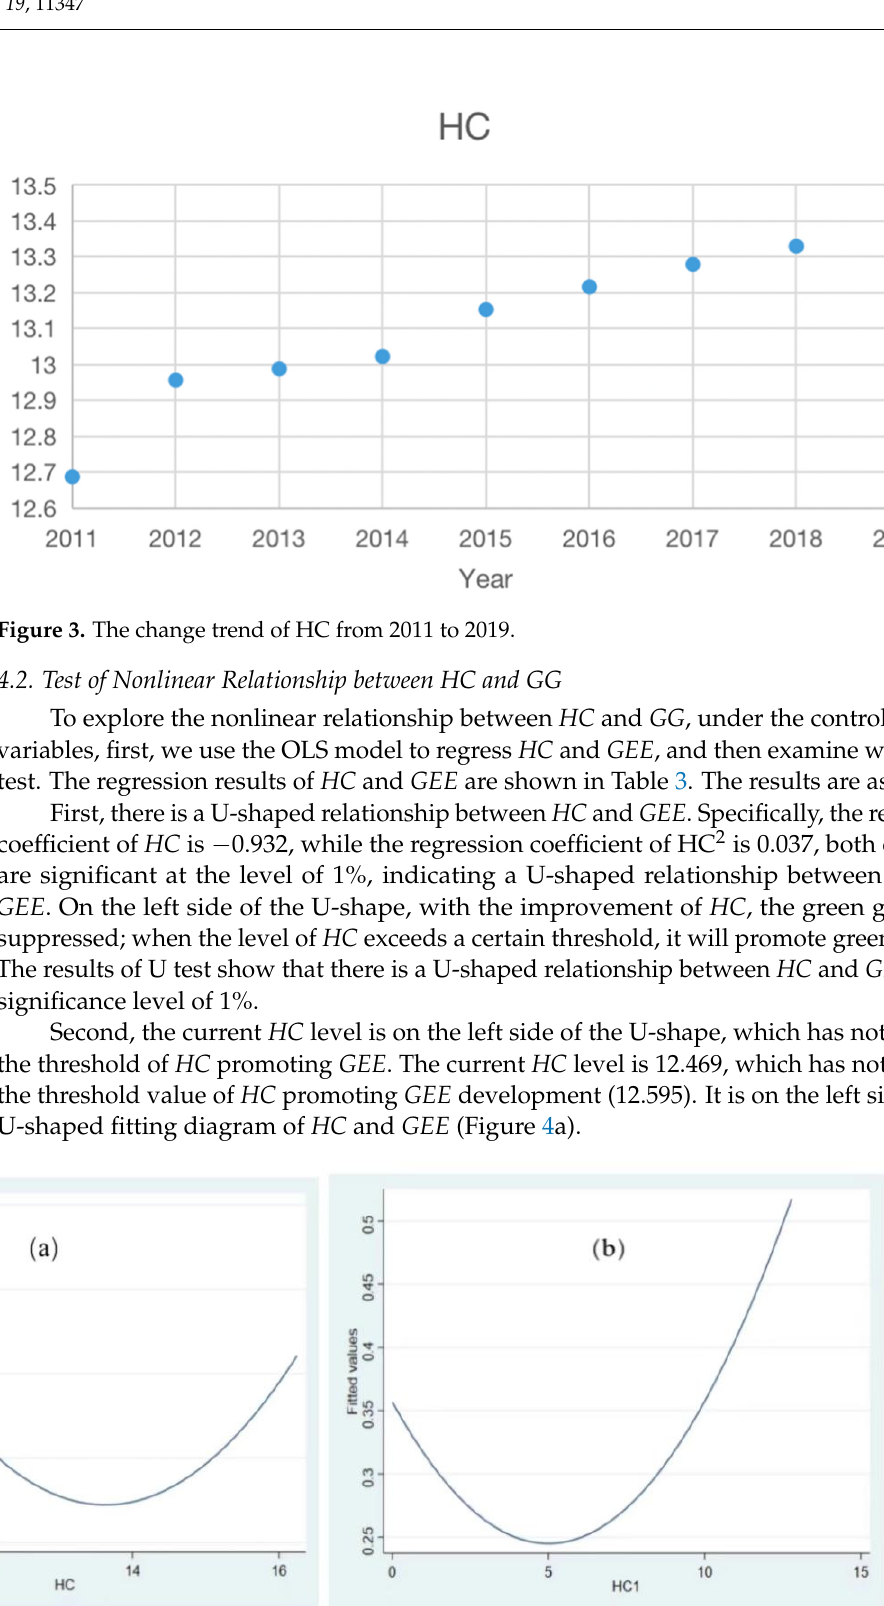
Table 3. Regression results of U-shaped relationship between HC and GEE.